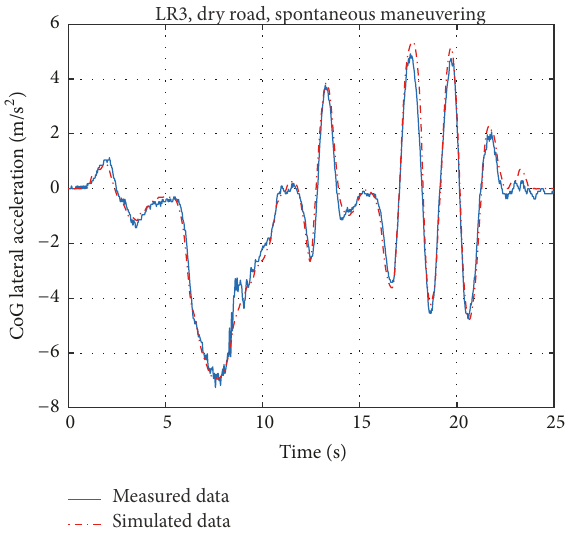
Figure 3: Model validation and comparison of lateral acceleration.